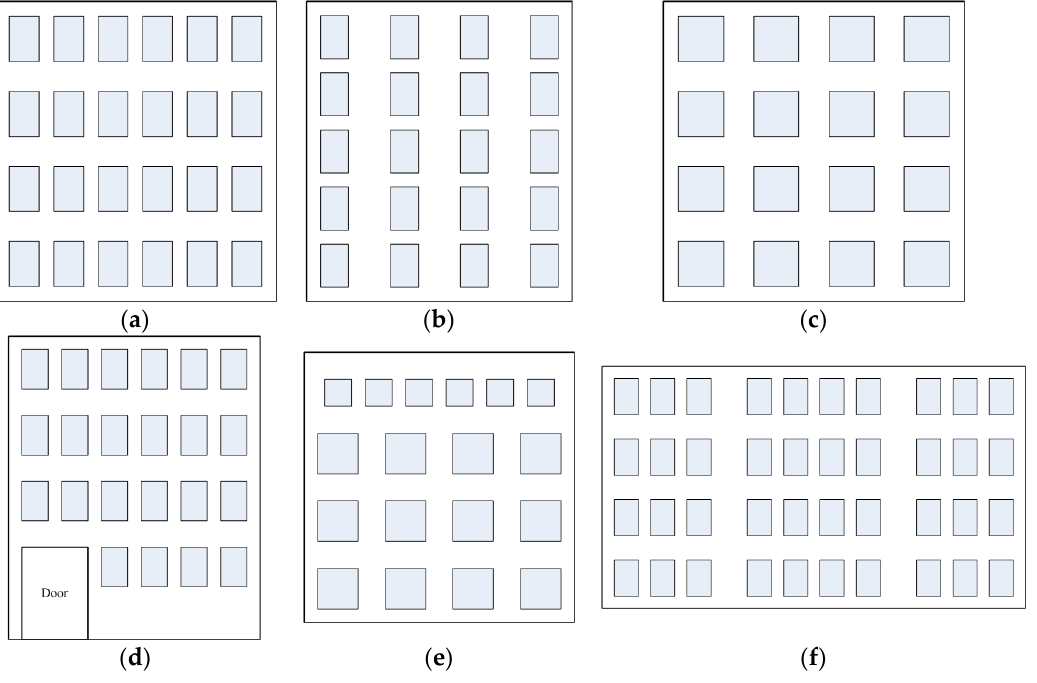
Figure 7. Typical distribution of windows on a façade: ( a ) tendency is in horizontal direction; ( b ) tendency is in vertical direction; ( c ) no tendency; ( d ) regularity is disturbed by a door; ( e ) windows are not equally-sized; ( f ) the façade is composed of three regular patterns.